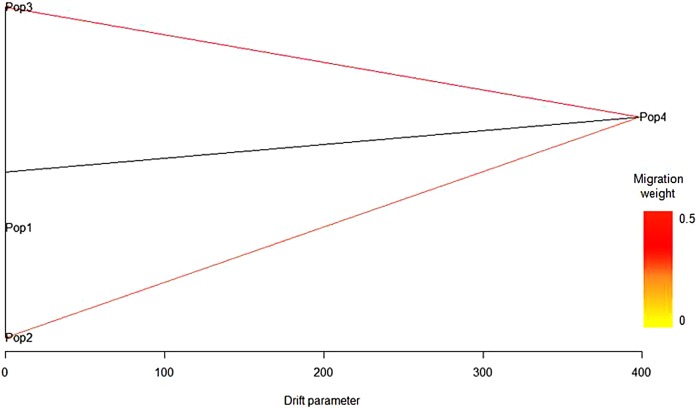
Predictive model based on log-likelihood and residual variance values obtained with TreeMix.The first migration event was predicted by TreeMix software from Syrian population (Pop4) toward the Italian population (Pop3) and a second migration edge was directed from the Syrian population (Pop4) to the Maltese population (Pop2). No migration events occurred between the Algerian population (Pop1) and the others.